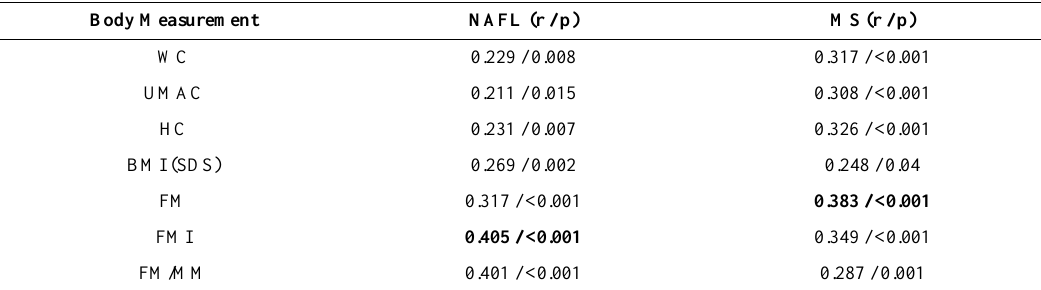
Table 3. Correlation coefficients of body measurements with fatty liver and MS